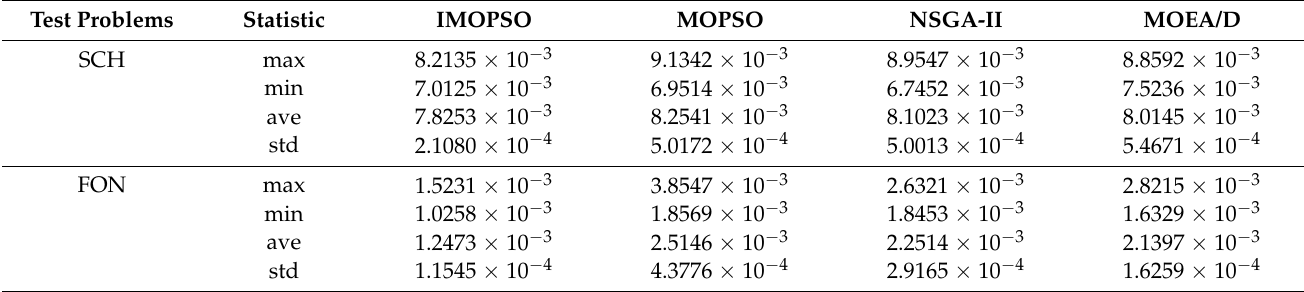
Table 2. Comparison of the GD index of four